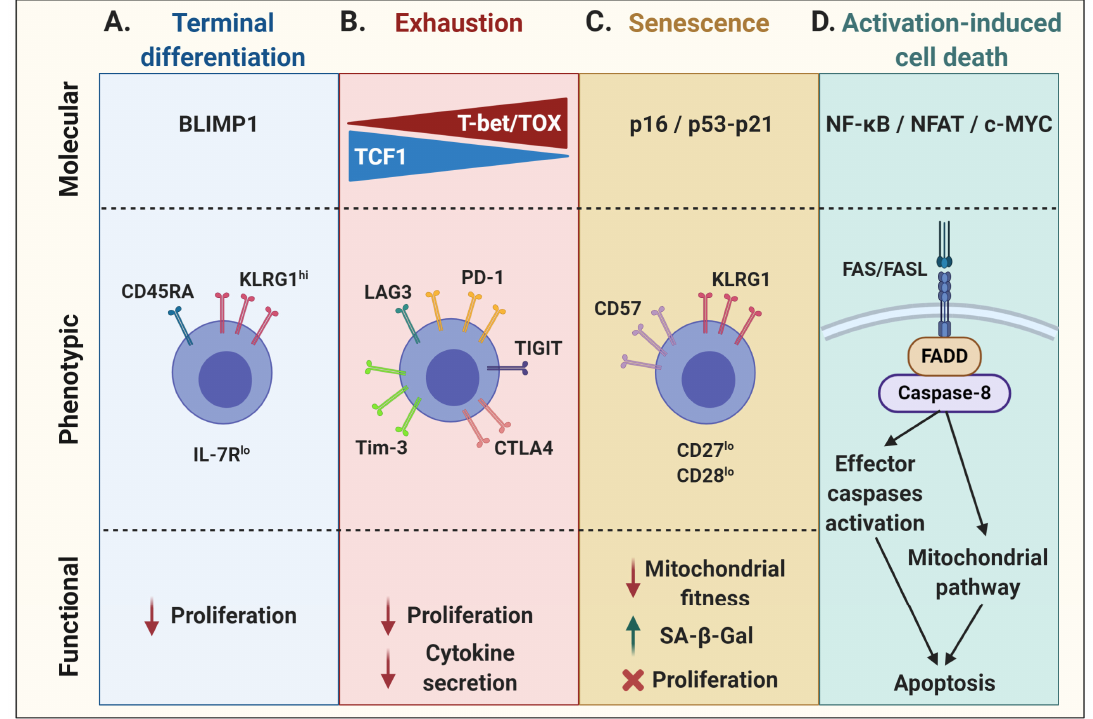
Figure 1. Molecular, phenotypic, and functional characteristics of T-cell dysfunctional states. ( A ) T-cell terminal differentia- tion, governed by the transcriptional repressor BLIMP1, is phenotypically associated with the re-expression of CD45RA, along with KLRG1, while downregulating IL-7R, leading to an impaired proliferation. ( B ) T-cell exhaustion is regulated by a gradual decrease in TCF1 and concordant increase in T-bet and TOX expression, associated with the upregulation of many inhibitory receptors. In addition to a diminished proliferative capacity, exhausted T cells become hyporesponsive, mainly shown by an impaired cytokine secretion capacity upon stimulation. ( C ) Senescent cells may engage various cell cycle regulators, such as p16 or p21 via p53 expression, to inhibit cell cycle progression. Phenotypically, these cells show upregulation of CD57 and/or KLRG1 at the cell surface, and downregulation of co-stimulatory molecules CD27 and CD28. It is associated with impaired mitochondrial functions, an increase in senescence-associated β -galactosidase (SA- β -Gal) activity, and proliferation arrest. ( D ) Activation-induced cell death requires the activation of a death receptor. Upon TCR stimulation, various transcription factors are induced, such as NF- κ B, NFAT, and c-MYC, which can lead to the expression of FASL. FASL may trigger the death receptor FAS on adjacent cells, activating caspase-8 and leading to direct effector caspase activation and/or mitochondrial release of cytochrome c, resulting in apoptosis. This figure was created with Bio- Render.com.